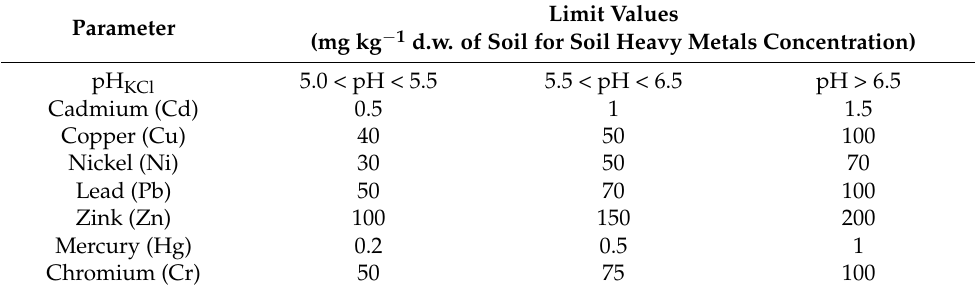
Table 2. Limits of Cd, Cu, Ni, Pb, Zn, Hg and Cr in sludge-treated agricultural soil (mg kg − 1 d.w. of soil)